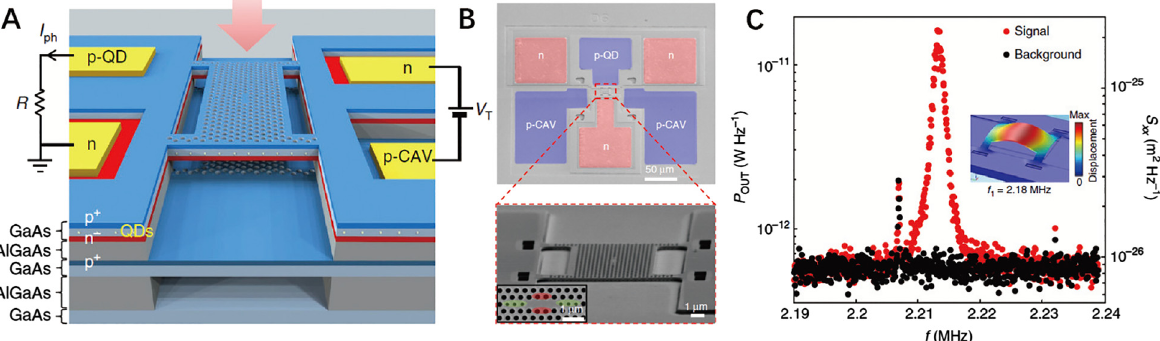
Figure 6: (A) Schematic of the tapered-fiber-interfaced optical cavity dispersively coupled with an array of nanomechanical resonators. Scanning electron micrograph (false color) of (B) doubly clamped SiN nanostring resonators and (C) microtoroid cavity. (D) Displacement density as a function of frequency. Inset: finite-element simulation of the string’s fundamental mode [84].